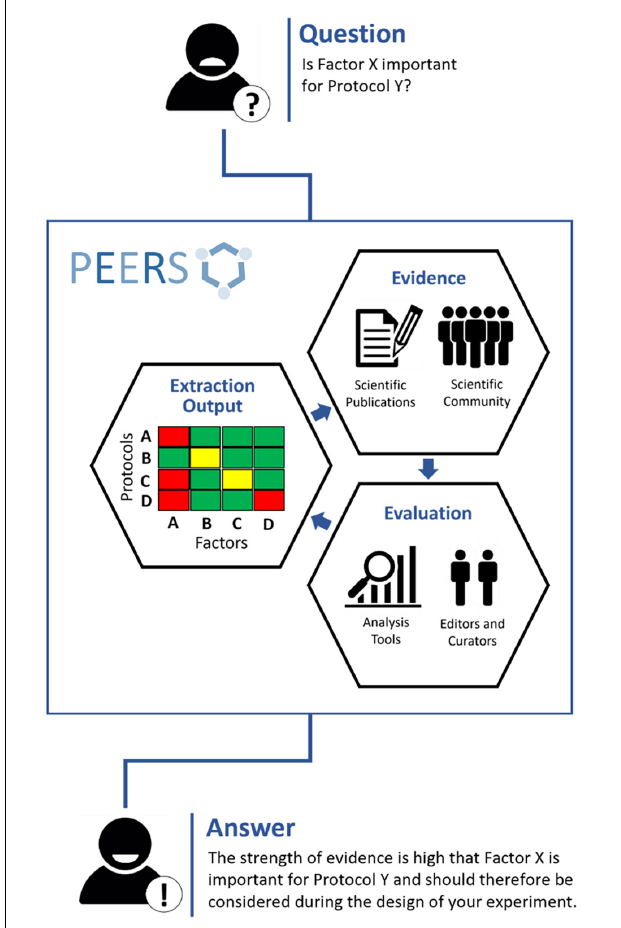
FIGURE 1 | Outline of the PEERS concept and workflow (the 3Es). To understand whether specific factors are relevant for certain methods/models (“protocols”), the PEERS workflow is based on different steps to collect information about selected factors/protocols from publications or the scientific community (“ Evidence ”); rate the strength of this information and provide mechanisms for editing, curating and maintaining the information/database (“ Evaluation ”); and present the outcome in a user-friendly and digestible form (“ Extraction Output ”) so that users will be provided with an answer helpful for their planned